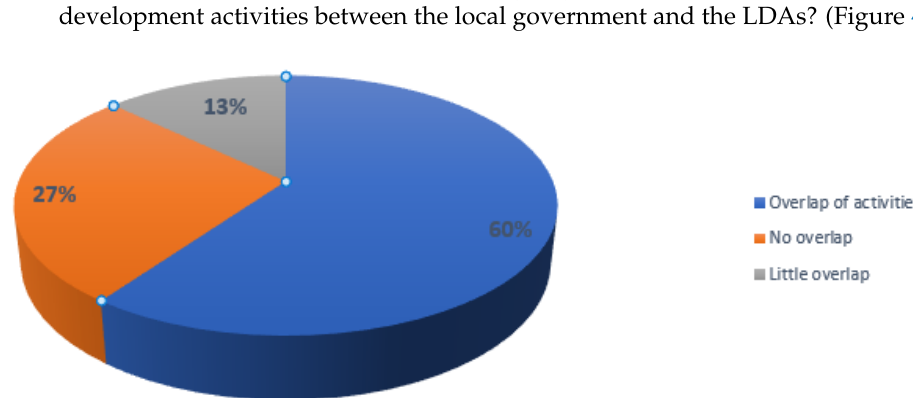
Figure 4. Overlapping activities w/ local government. Source: Research data 2019-authors.